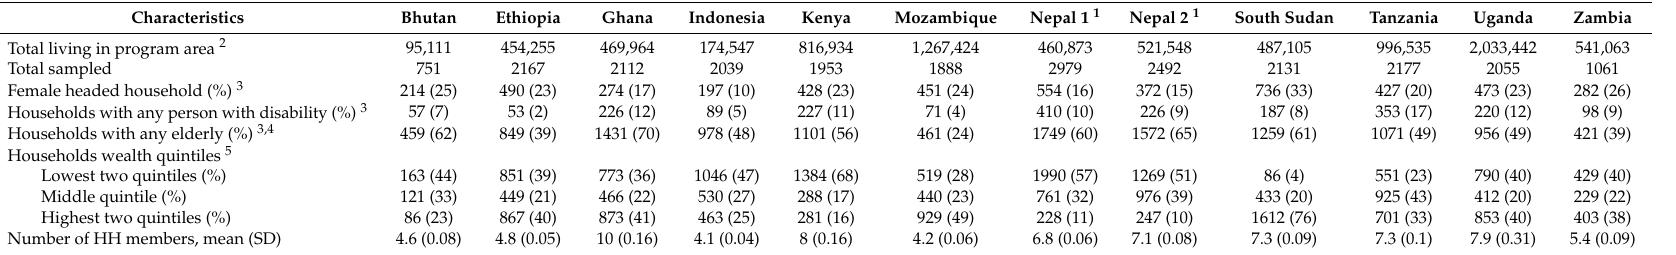
Table 1. Characteristics of the study population at baseline across 11 countries, 2014 ( n =